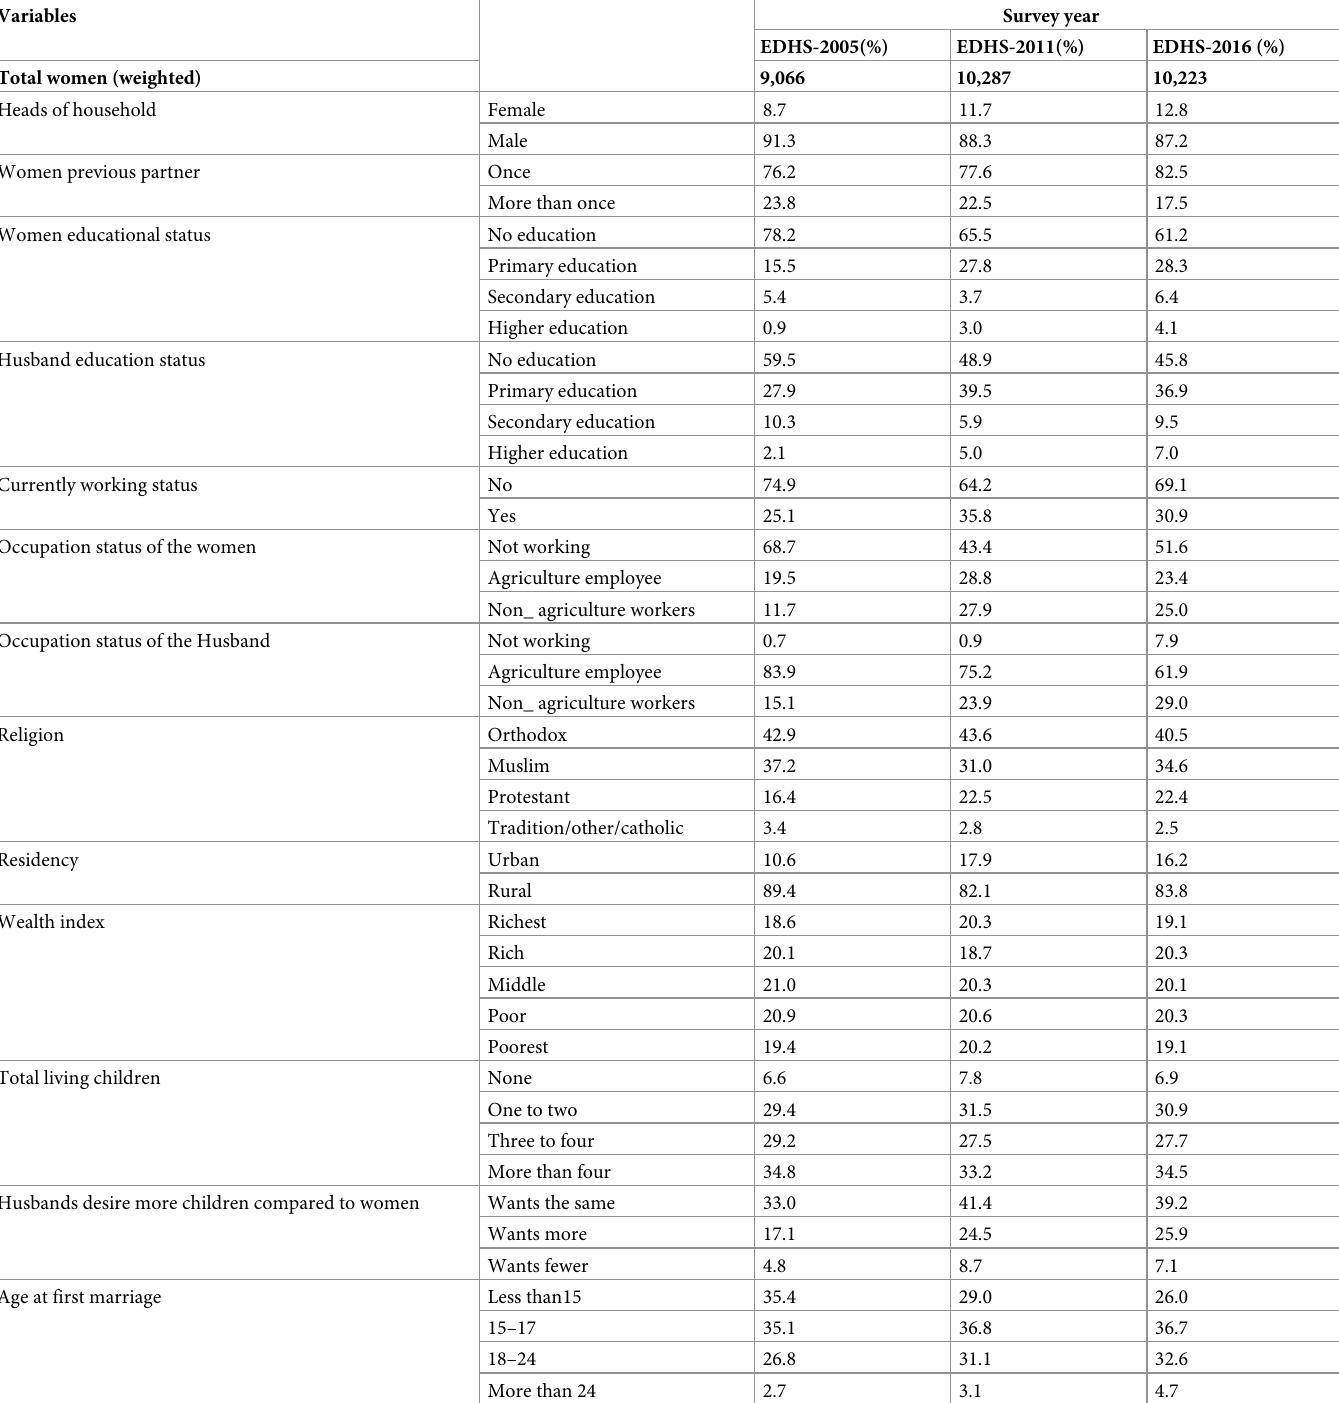
Table 1. Respondents’ distribution according to demographic and socio-economic variables from 2005-to 2016 in